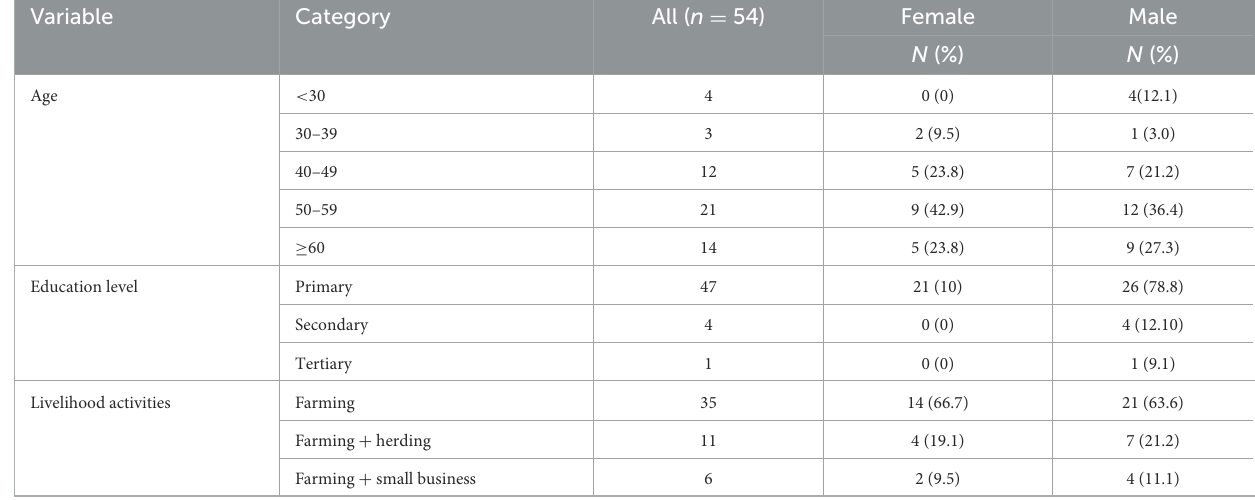
TABLE 1 Key demographic information about farmer respondents for 45 farmers with maize and bean fields in Narumu Ward, Kilimanjaro Region, Tanzania.